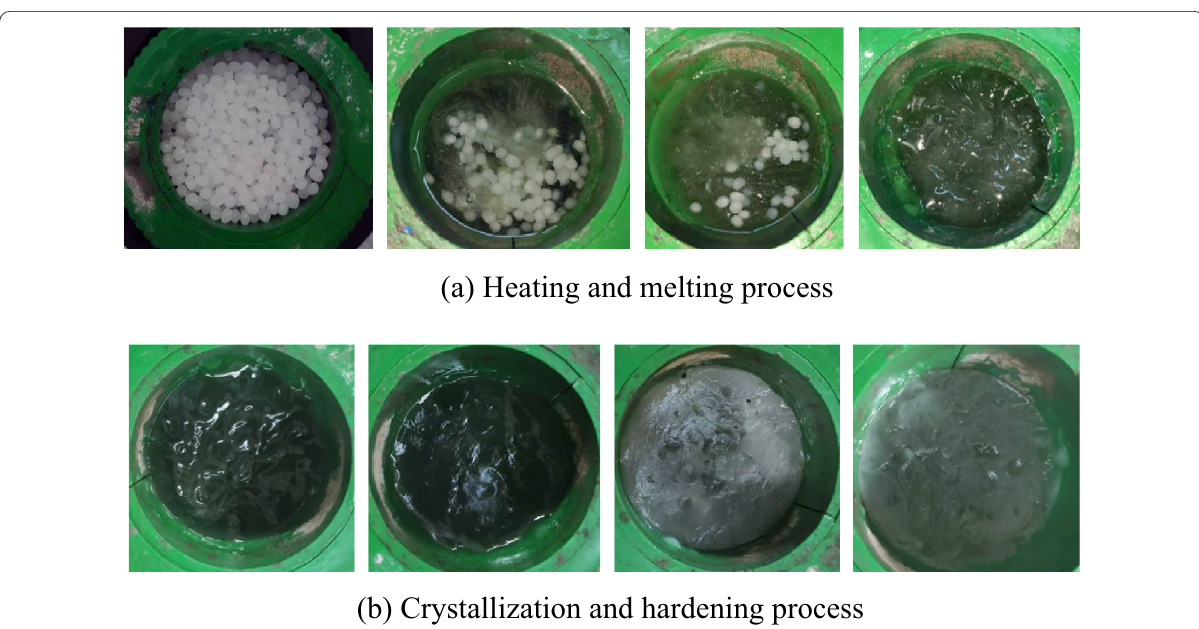
Fig. 2 Sample preparation of PCL granules.